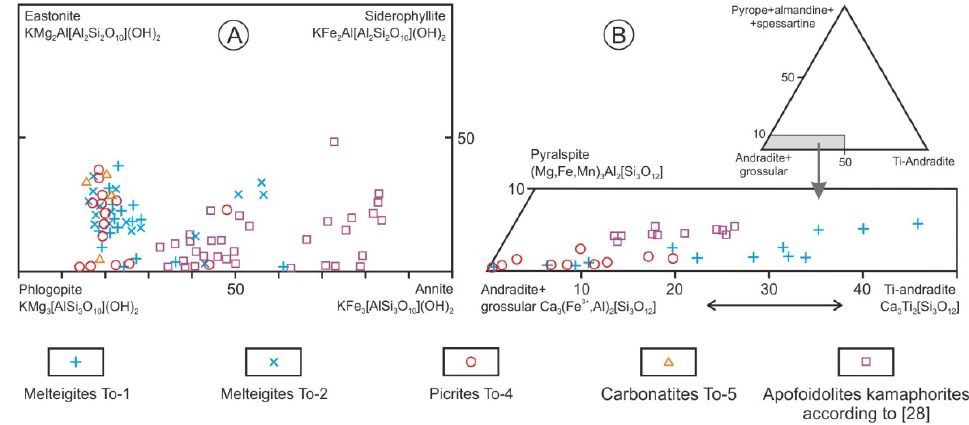
Figure 5. Composition diagrams of biotites ( A ) and garnets ( B ).